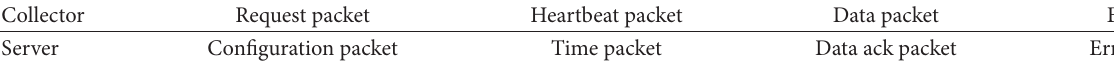
Table 2: Communication data packet.